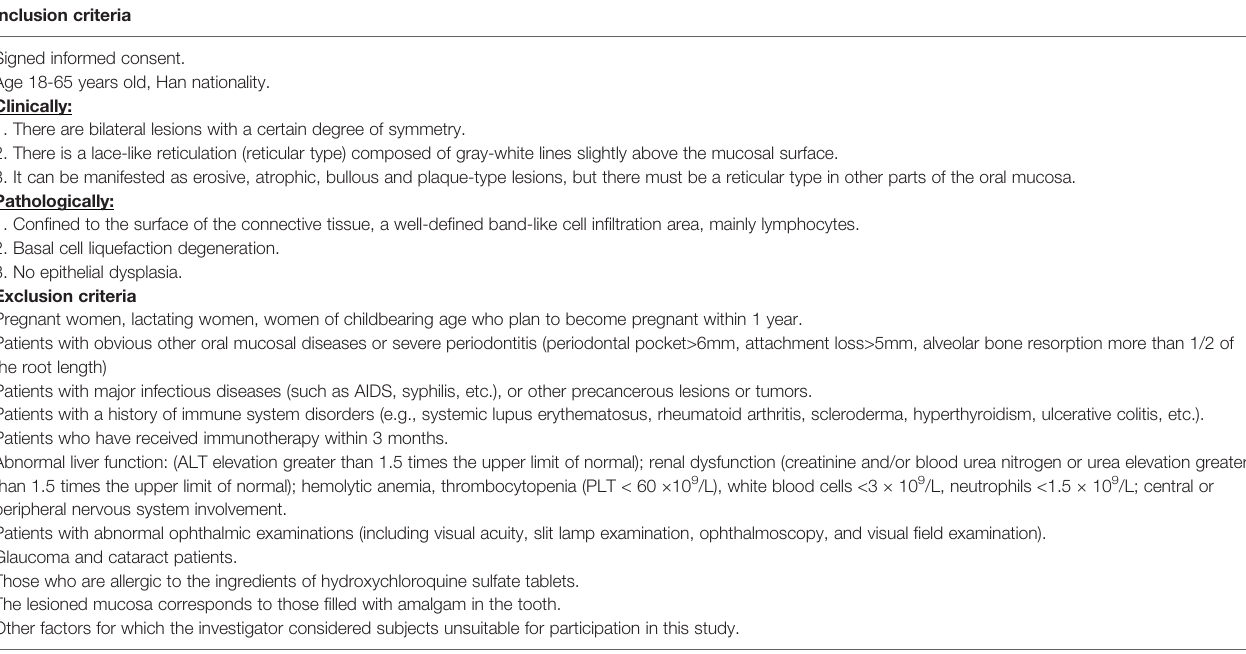
TABLE 1 | The include exclusion